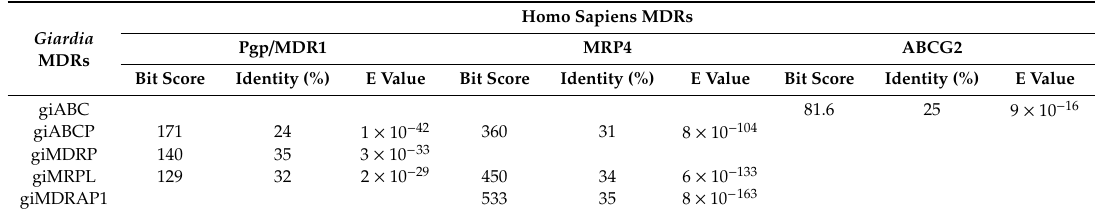
Table 3. Protein BLAST results of multidrug resistance (MDRs) in Giardia Data Base.